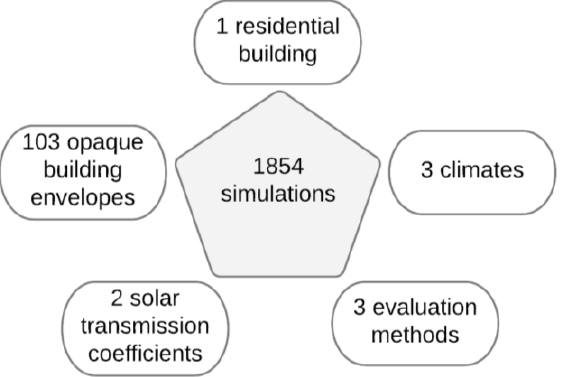
Figure 4. Overview of case studies: Evaluation of 3 heat transfer models for buildings with different thermal inertia and different solar transmission coefficients.